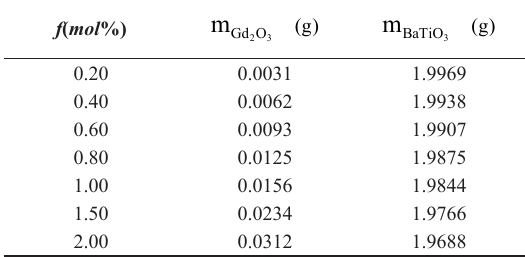
Table 1. Gadolinium concentrations and reagent masses for the samples used in this work.